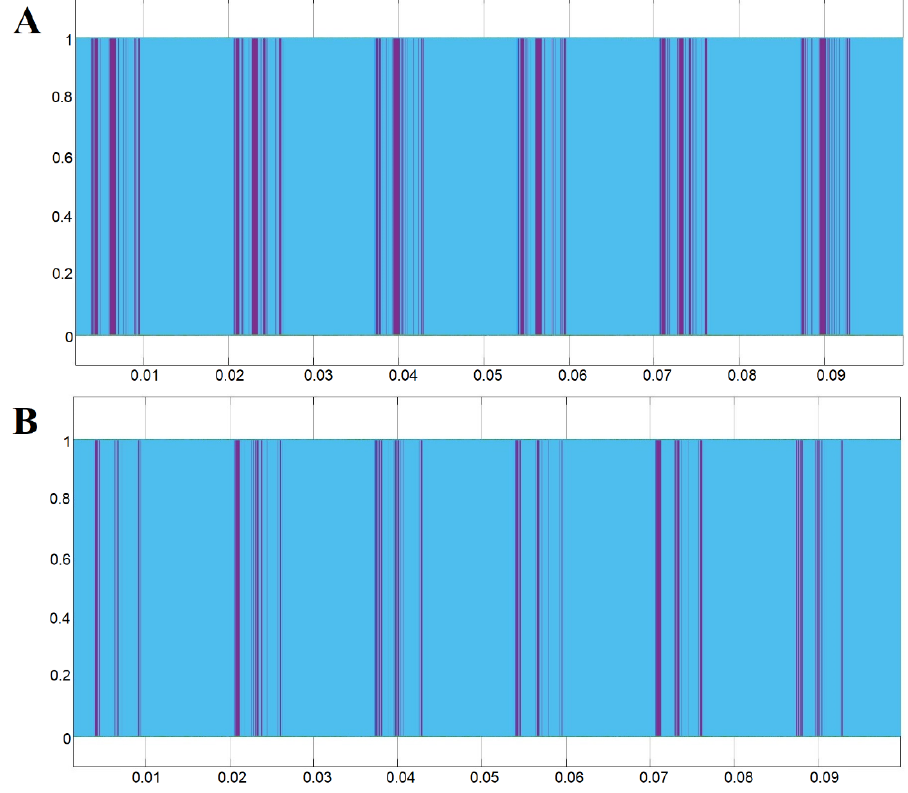
Figure 17. Representation of switching signals. ( A ) For horizon N = 2 and ( B ) for modified horizon N = 2.